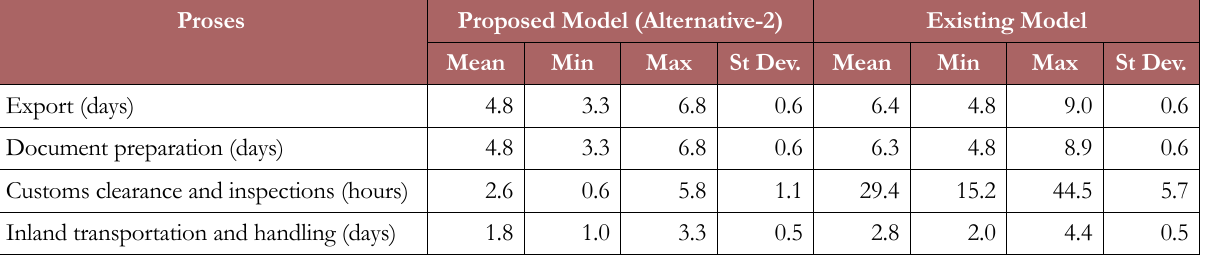
Table 9. Result of